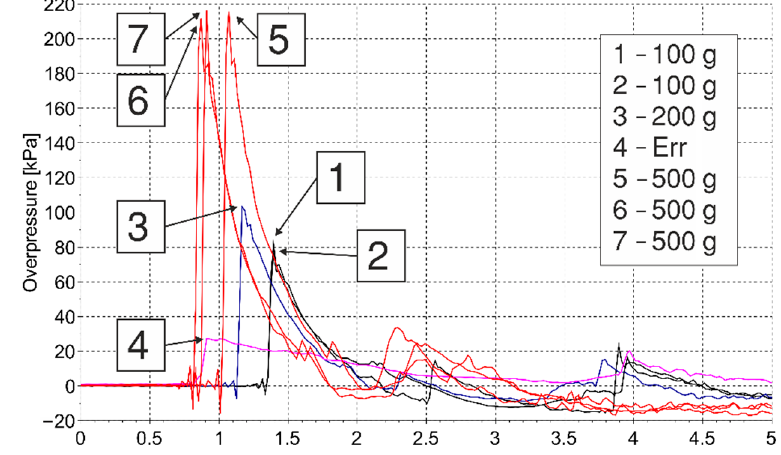
Figure 2. Overpressure measurements at 1 m.